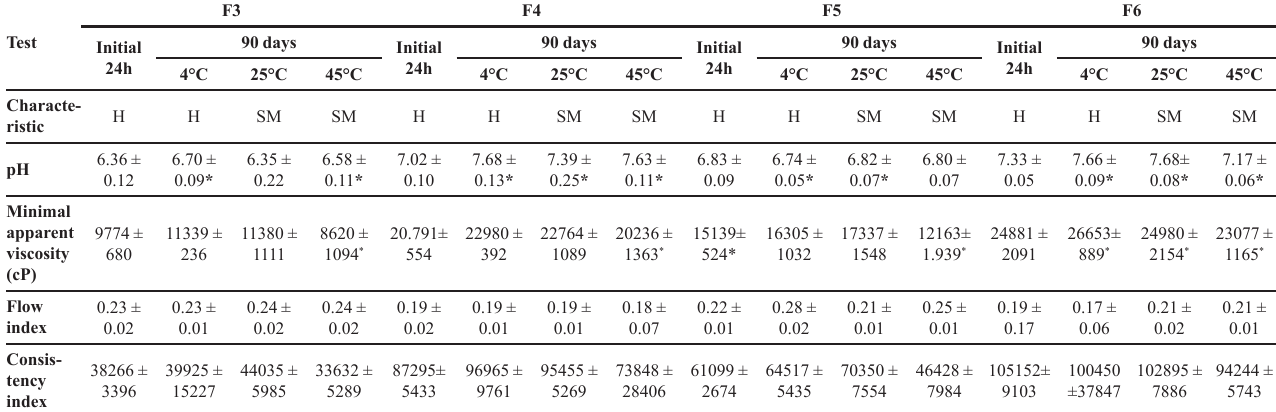
TABLE III ‑ Results of accelerated stability tests of O/W emulsions with and without 0.5% of Kalanchoe brasiliensis extract